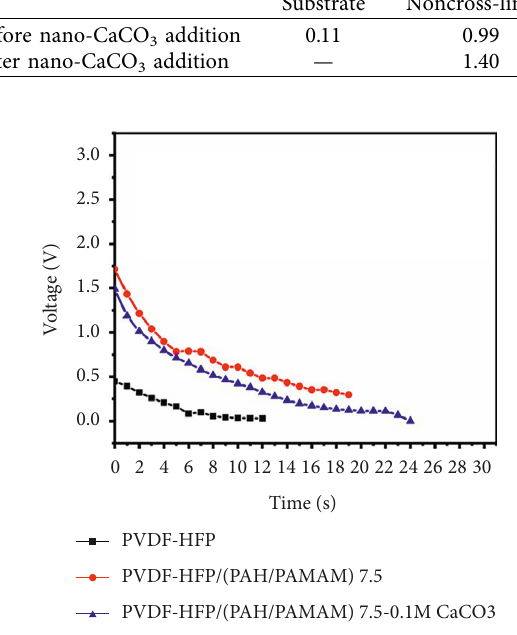
Figure 8: Output voltage-time curve of PVDF-HFP, PVDF-HFP/ (PAH/PAMAM) 7.5 , and PVDF-FP/(PAH/PAMAM) 7.5 -CaCO 3 af- ter